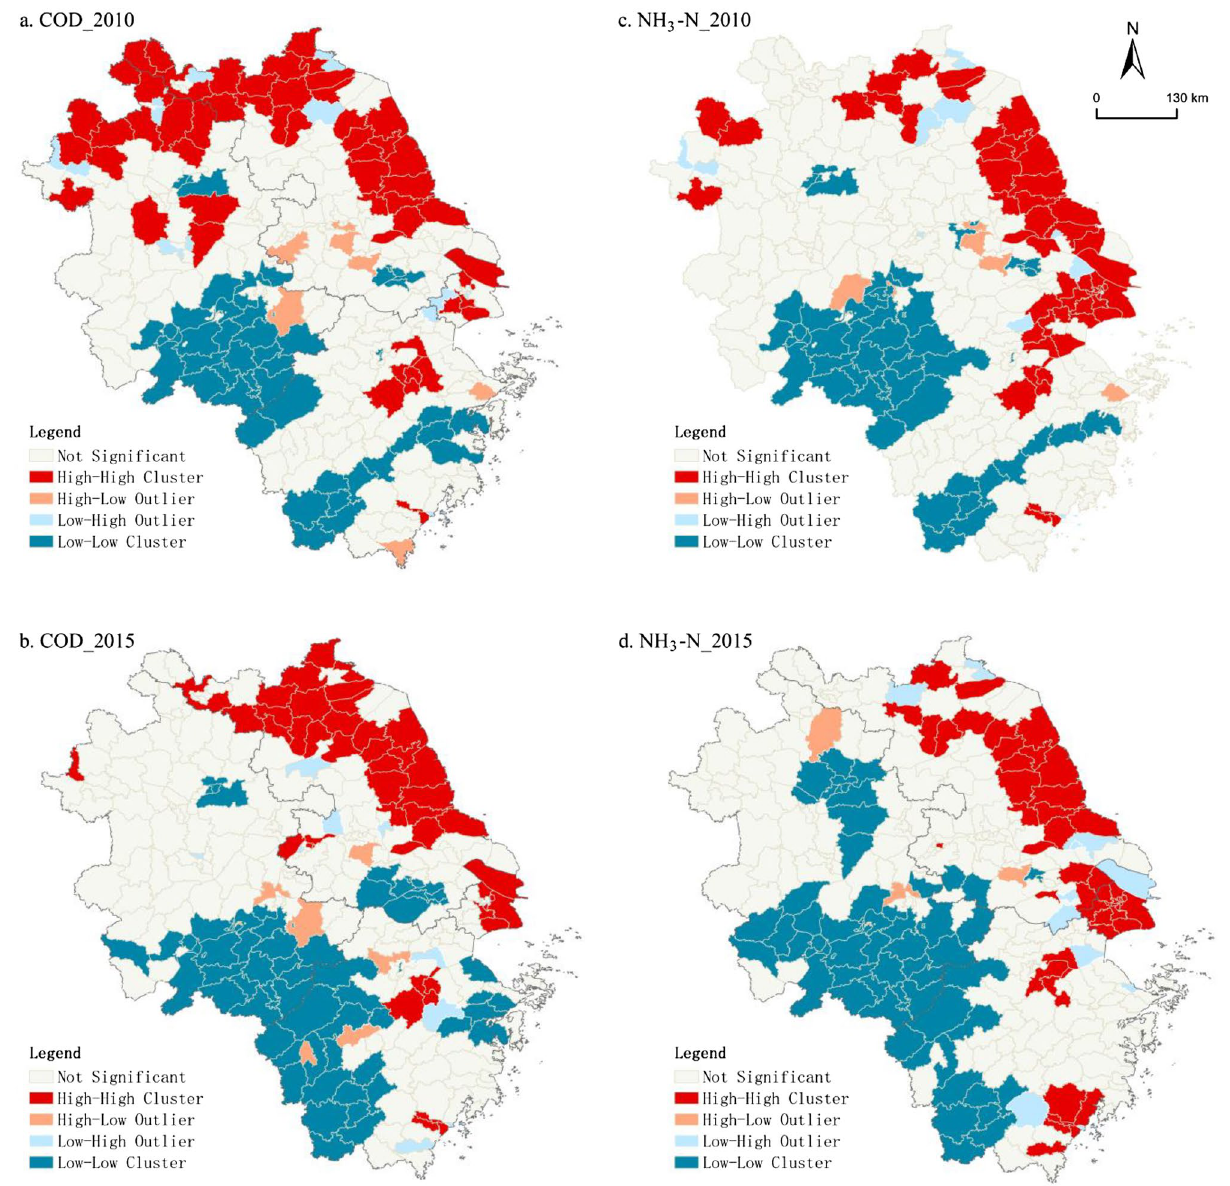
Figure 5. Local spatial agglomeration of water pollutant emissions in the YRD. Map was generated by ArcGIS 10.2 (http:// www. esri. com/ softw are/ arcgis/ arcgis- for- deskt